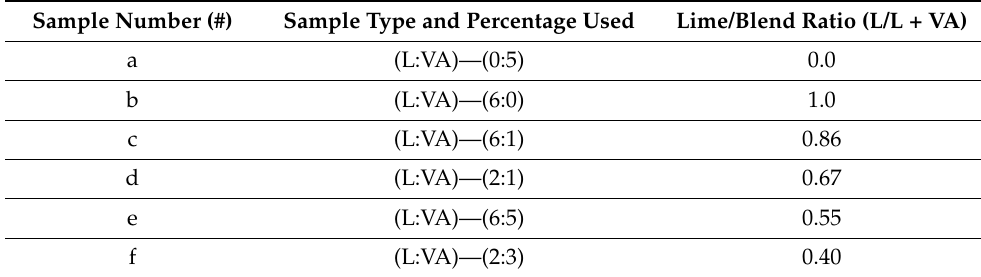
Table 4. Tested samples for Raman spectroscopy and laser-scanning microscopy (LSM).